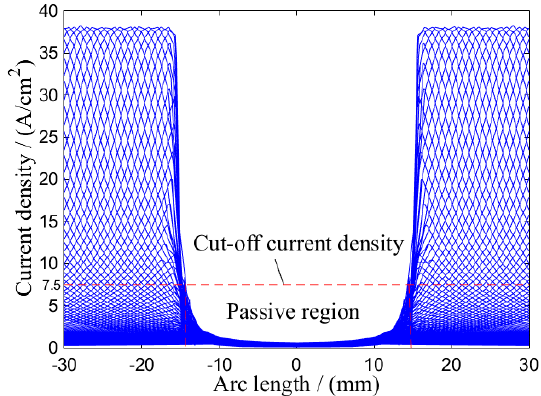
Figure 7. Current density distribution on the anode surface at different rotation angles.